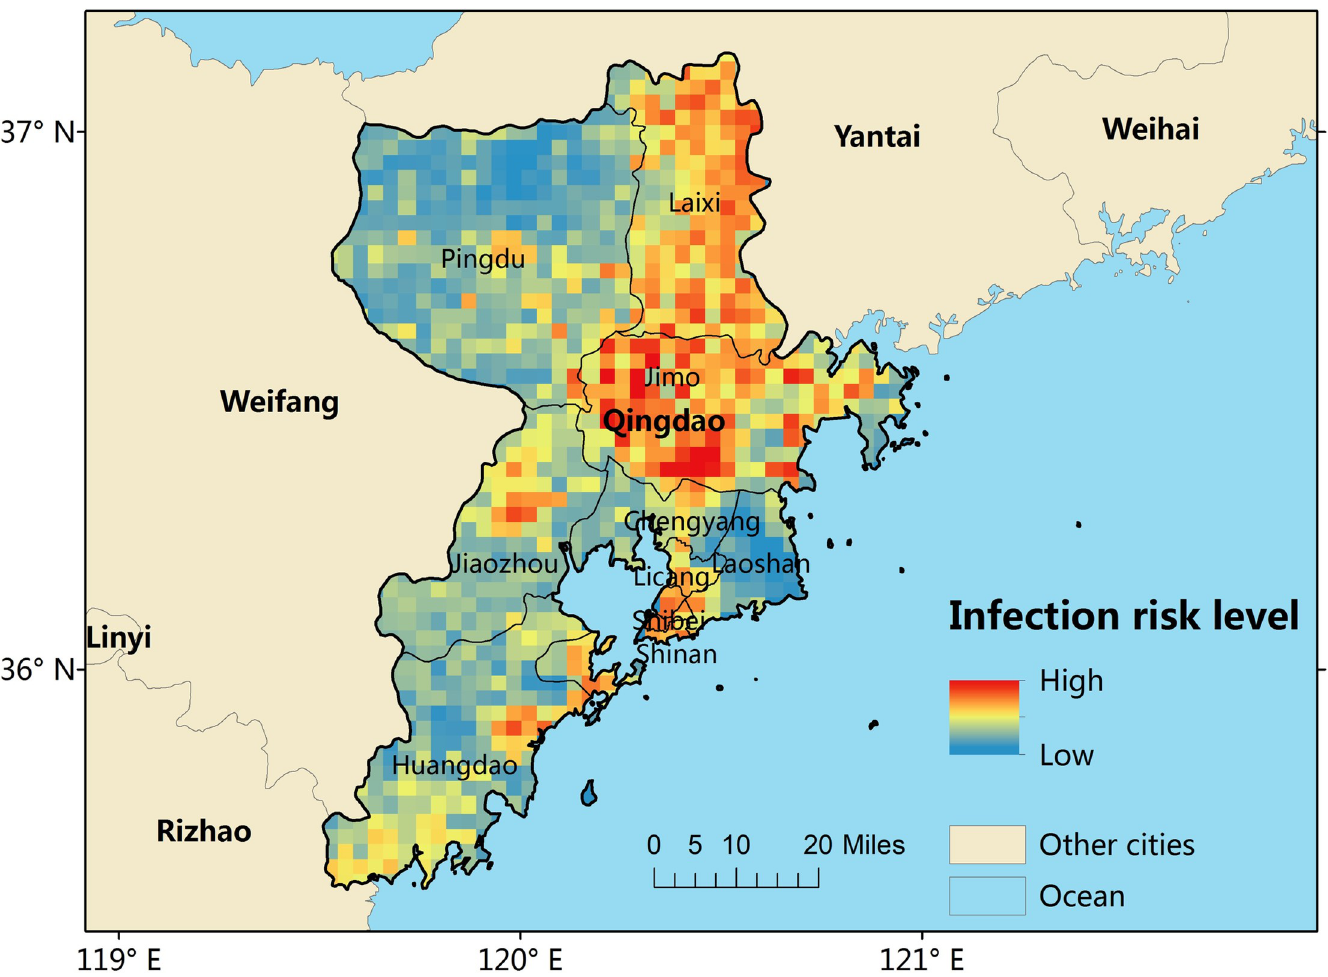
Fig 3. Maps of environmental suitability for scrub typhus in Qingdao city